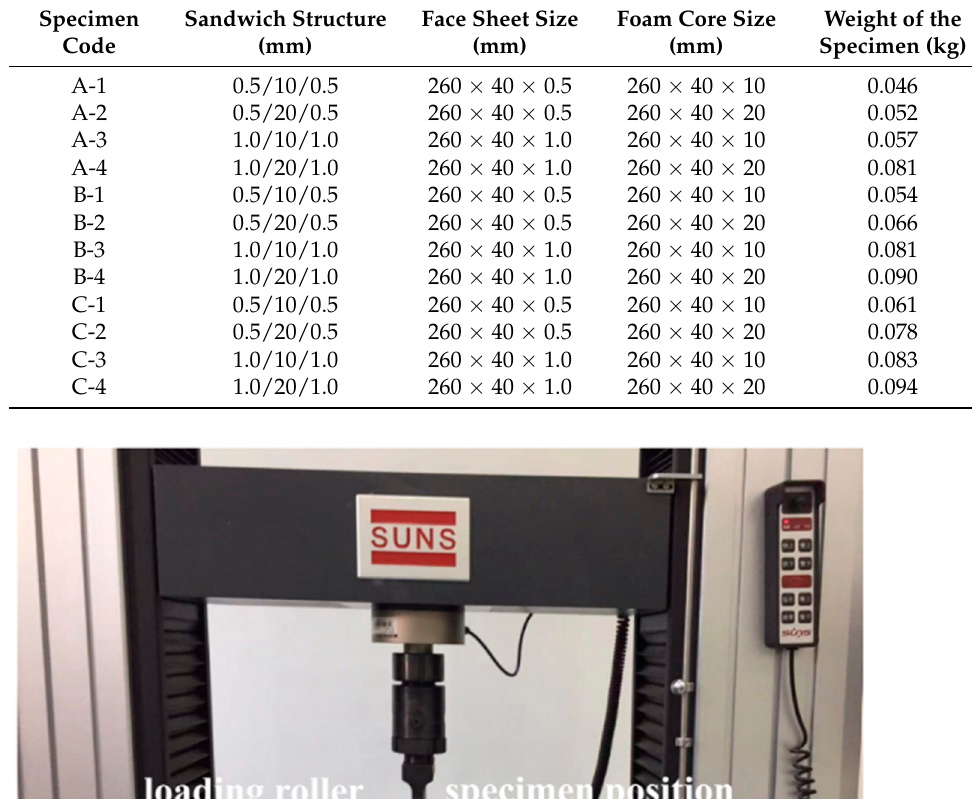
Table 1. Sizes of face sheet and foam core, along with the weight of the tested specimen.